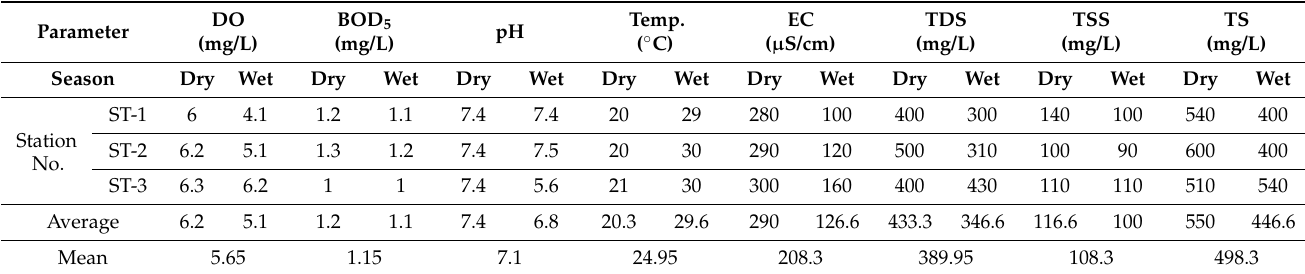
Table 2. Water quality during the dry and wet season in 2010.